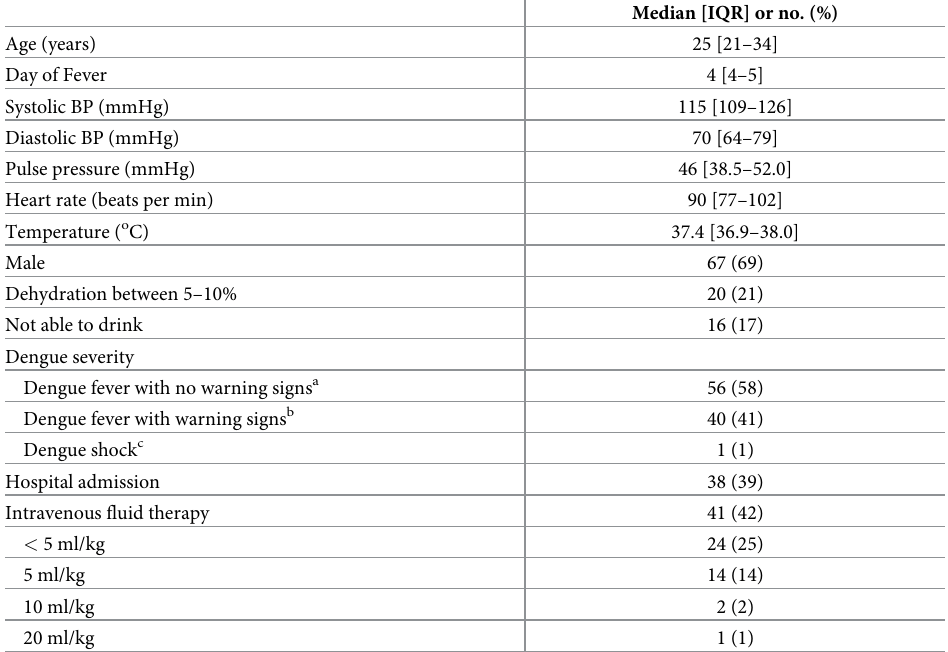
Table 1. Patient and Clinical Characteristics at Time of Triage.